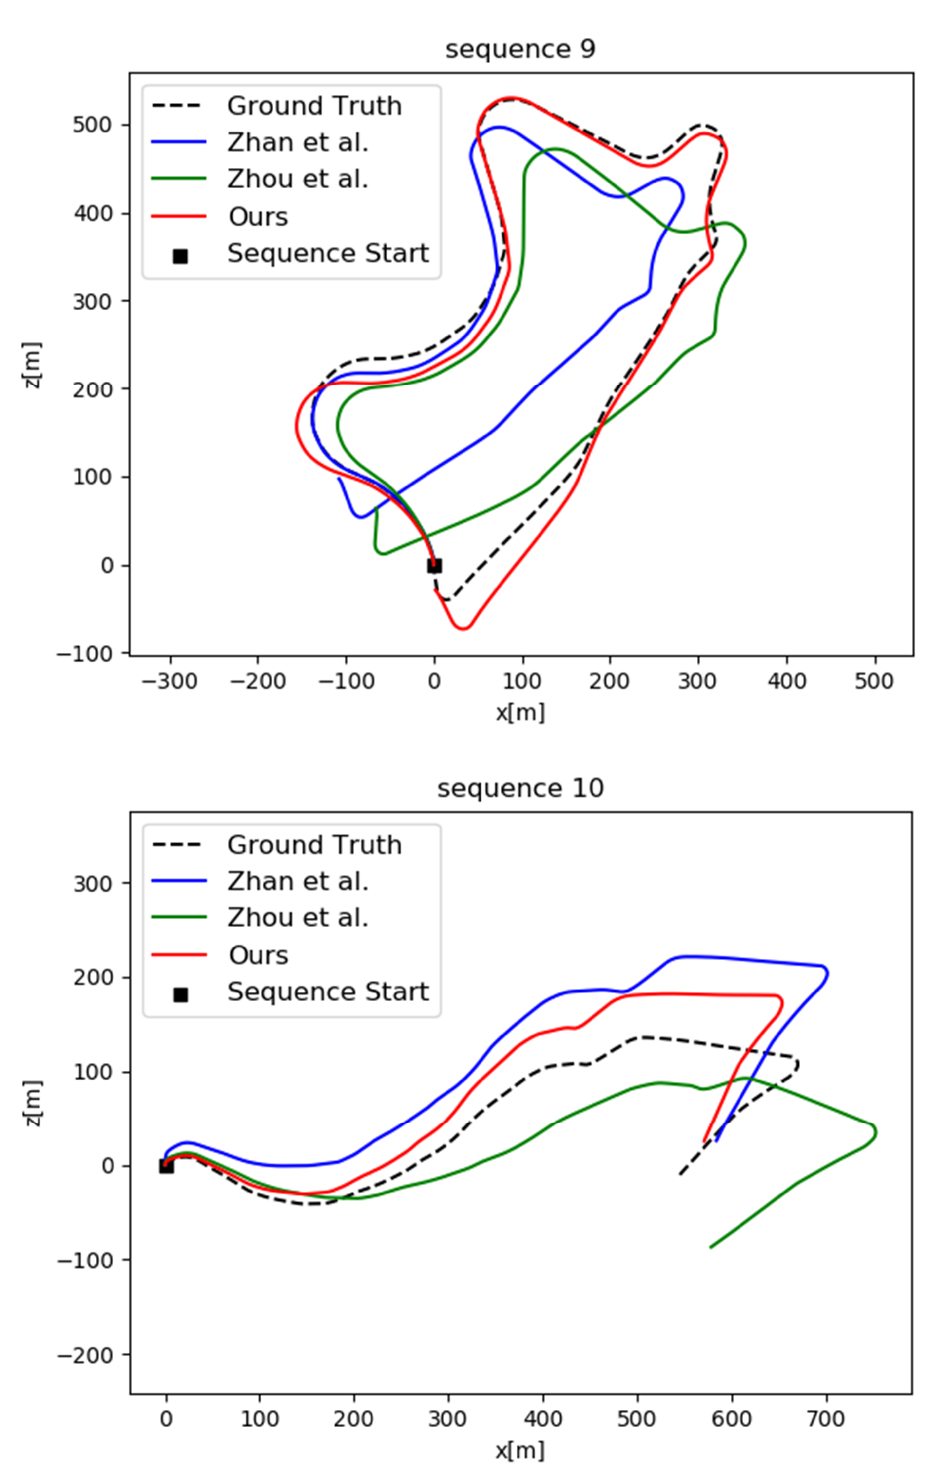
Figure 3. Comparison of trajectories produced by different methods on the KITTI sequence 09 and 10.